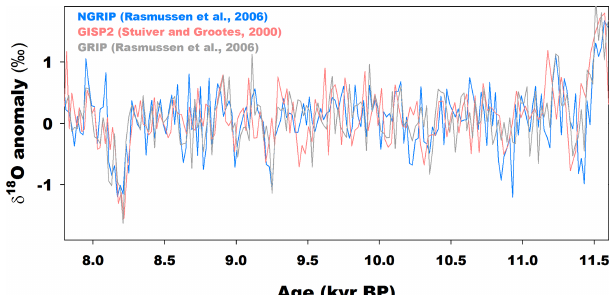
Figure 5. Comparison of Greenland oxygen isotope ratios from NGRIP (blue, Rasmussen et al., 2006), GRIP (grey, Rasmussen et al., 2006) and GISP2 (red, Stuiver and Grootes, 2000). All time se- ries were high-pass-filtered with 1/1800-year window. Note that the cooling amplitude at 10.3ka is smaller than 8.2 and 9.3ka events in NGRIP records, but this is not clear in GRIP and GISP2 ice